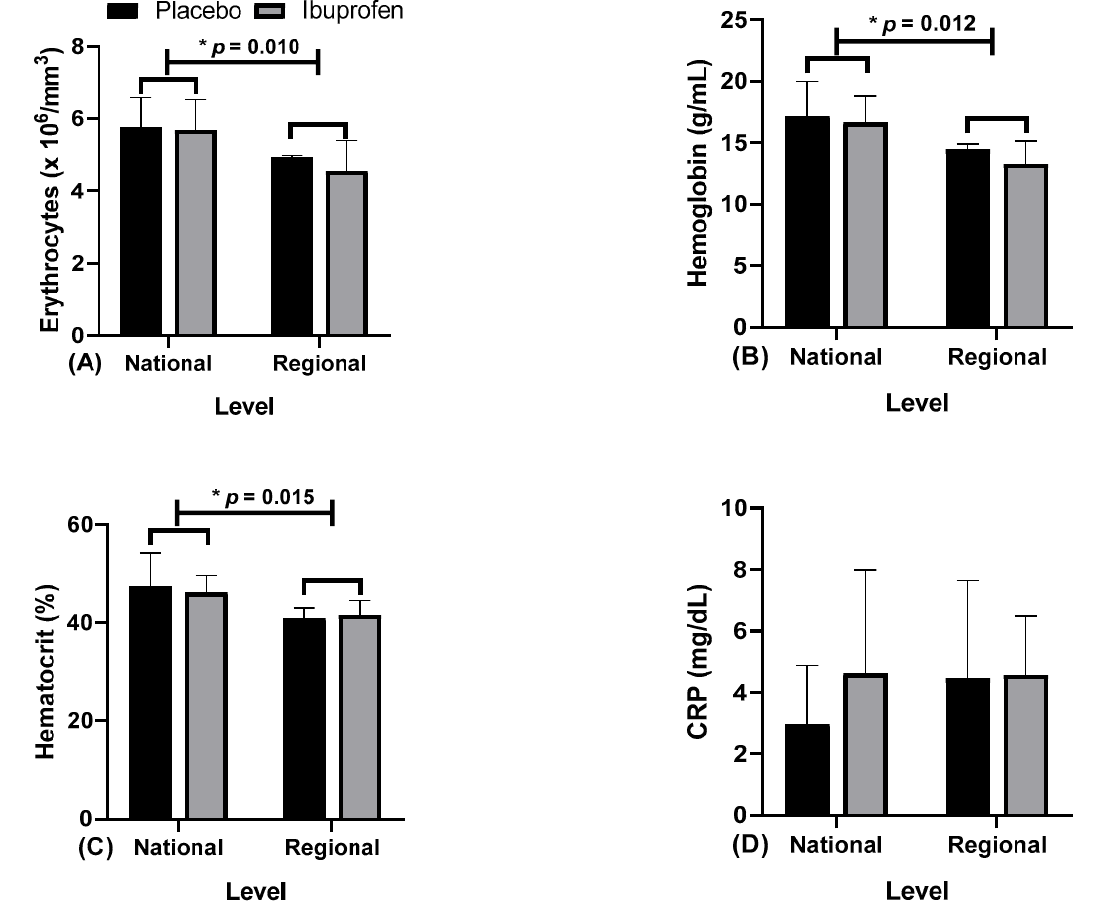
Figure 8. Blood markers: ( A ) erythrocytes; ( B ) hemoglobin; ( C ) hematocrit; and ( D ) C-reactive protein (CRP) with the use of placebo (PLA) and ibuprofen (IBU) at the regional and national levels of training. * p < 0.005.